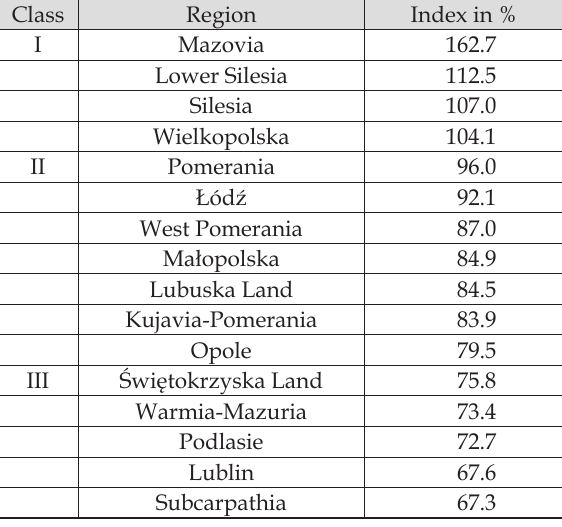
Table 5. Classification of regions by per capita GDP in